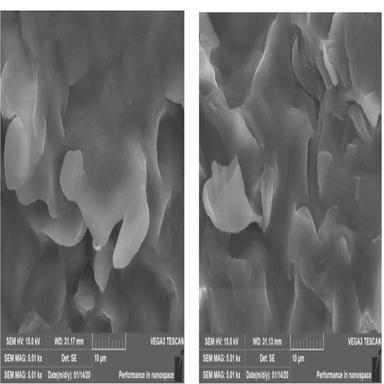
FESEM micrographs of a) PPC1-0.1% before thermal cycle b) PPC1-0.1% after 200 thermal cycles.